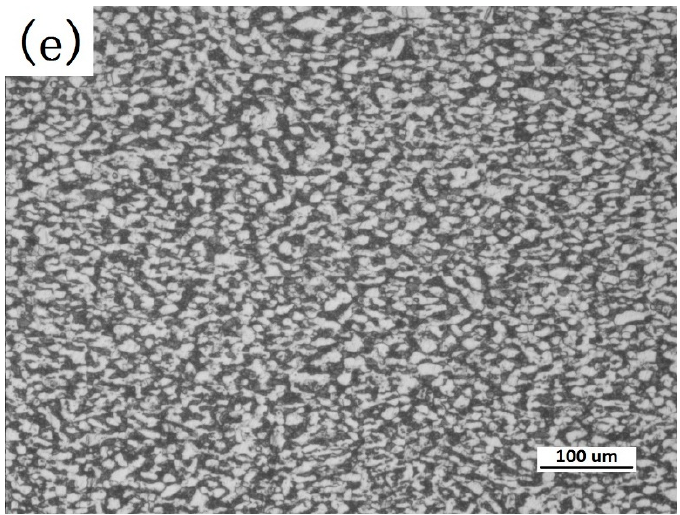
Figure 4. Microstructure of TA15 titanium alloy specimens compressed to strain 0.9 at 1223 K at different strain rates: ( a ) 0.001 s − 1 , ( b ) 0.01 s − 1 , ( c ) 0.1 s − 1 , ( d ) 1 s − 1 , and ( e ) 10 s − 1 .